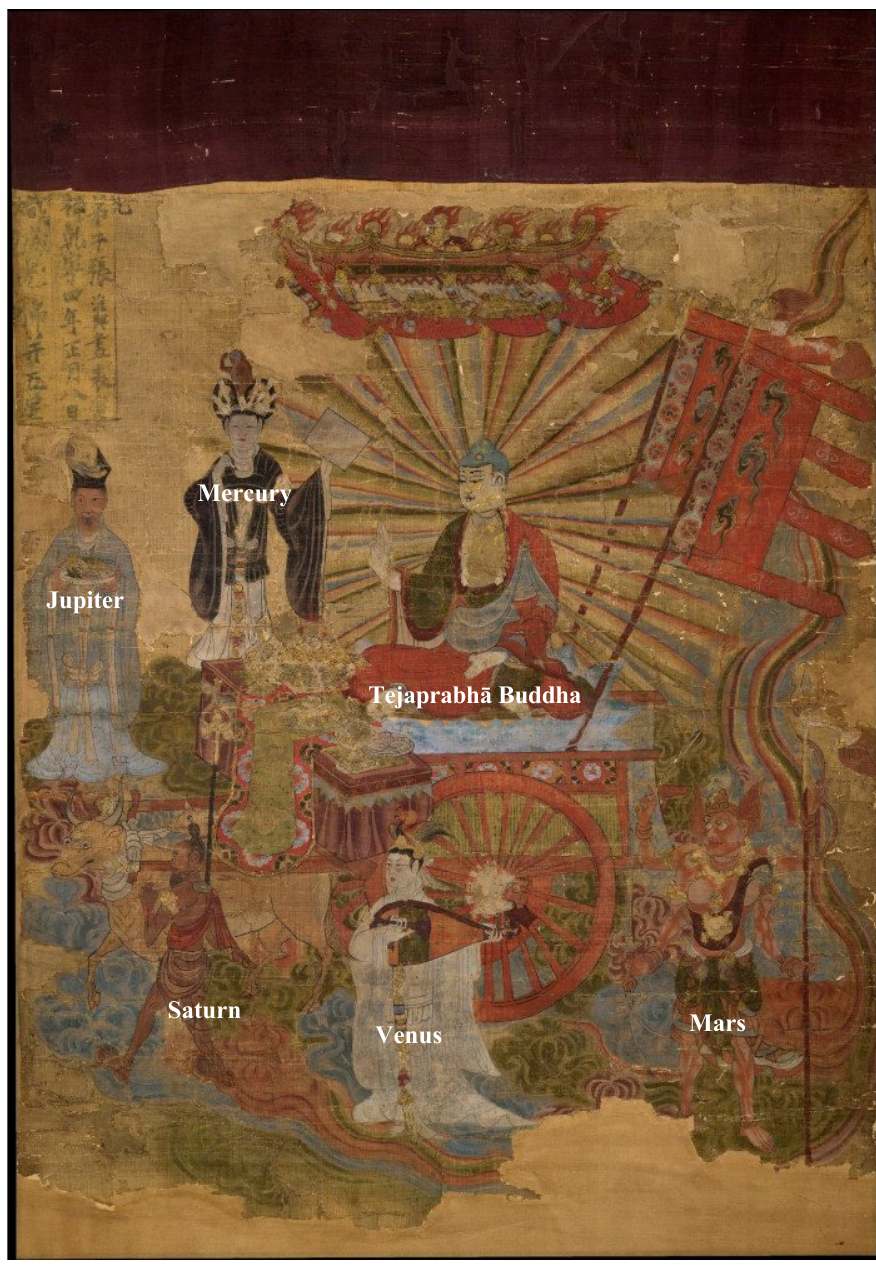
Figure 2. Iconographical annotation of Figure 1.